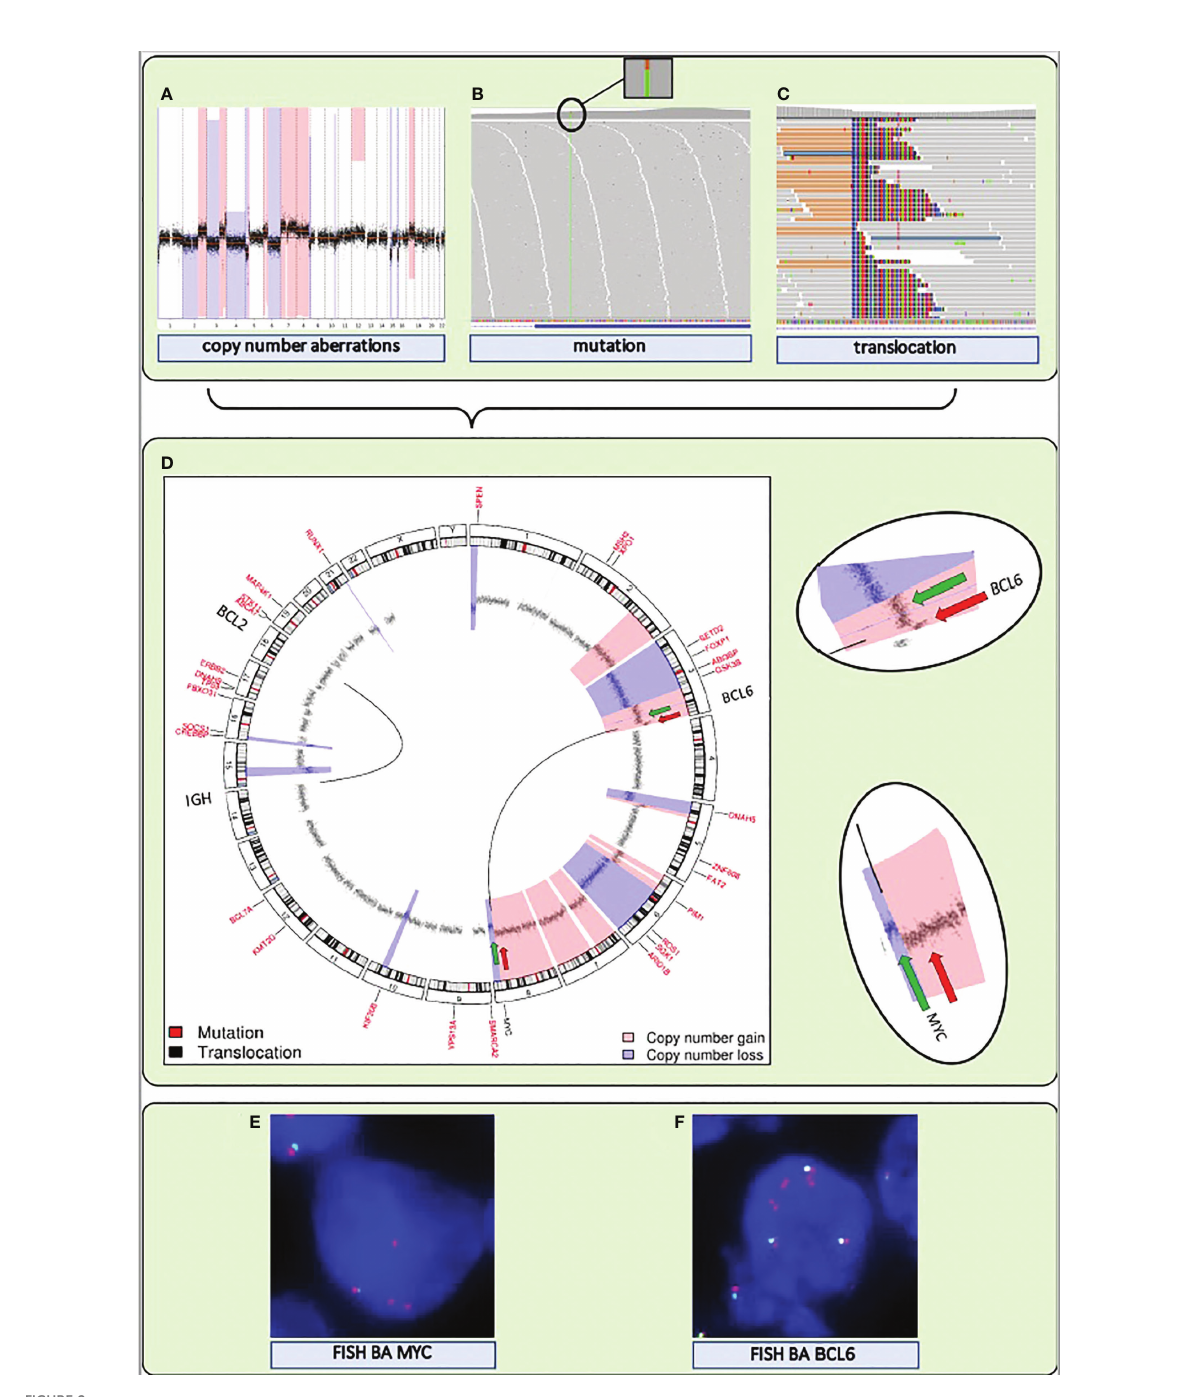
FIGURE 2 A single NGS assay to detect somatic mutations and structural variations, including translocations and CNAs, from DNA extracted from FFPE tissue. (A – C) Visualization of the detection by NGS of CNAs, mutations, and translocations for a DLBCL sample. (A) Genome-wide chromosomal CNAs. x-axis shows chromosomes 1 to 22, from left to right, y-axis shows copy number gains (light red) and copy number losses (blue). (B) Screenshot of high coverage (200X) NGS sequence reads aligned to the reference genome highlighting a somatic mutation in KMT2D . (C) Screenshot of high coverage (200X) NGS sequence reads aligned to the reference genome highlighting a translocation breakpoint in MYC . (D) A circular representation of the genome depicting mutations (genes denoted in small red letters), translocations (genes denoted with large black letters connected by black lines) and CNAs (inner circle: black dots are measurement bins and called losses are colored in blue and gains in light red). Green and red arrows point to the position of break apart (BA) FISH probes that were used as a control for the translocations detected by NGS. (E) FISH BA MYC. (F) FISH BA BCL6. Integrated NGS analysis explains aberrant FISH pattern: a loss (green arrow) and a gain (red arrow) at the MYC locus coincide with a single (green arrow) and double gain (red arrow) at the translocation partner BCL6